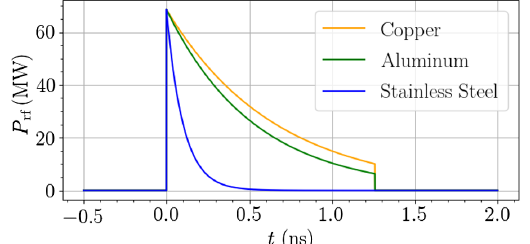
FIG. 17. rf power envelope at the end of a 0.5-m section of the A-STAR CWG made from copper ( 5 . 8 × 10 7 S m − 1 ), aluminum ( 3 . 8 × 10 7 S m − 1 ), and stainless steel ( 1 . 35 × 10 6 S m − 1